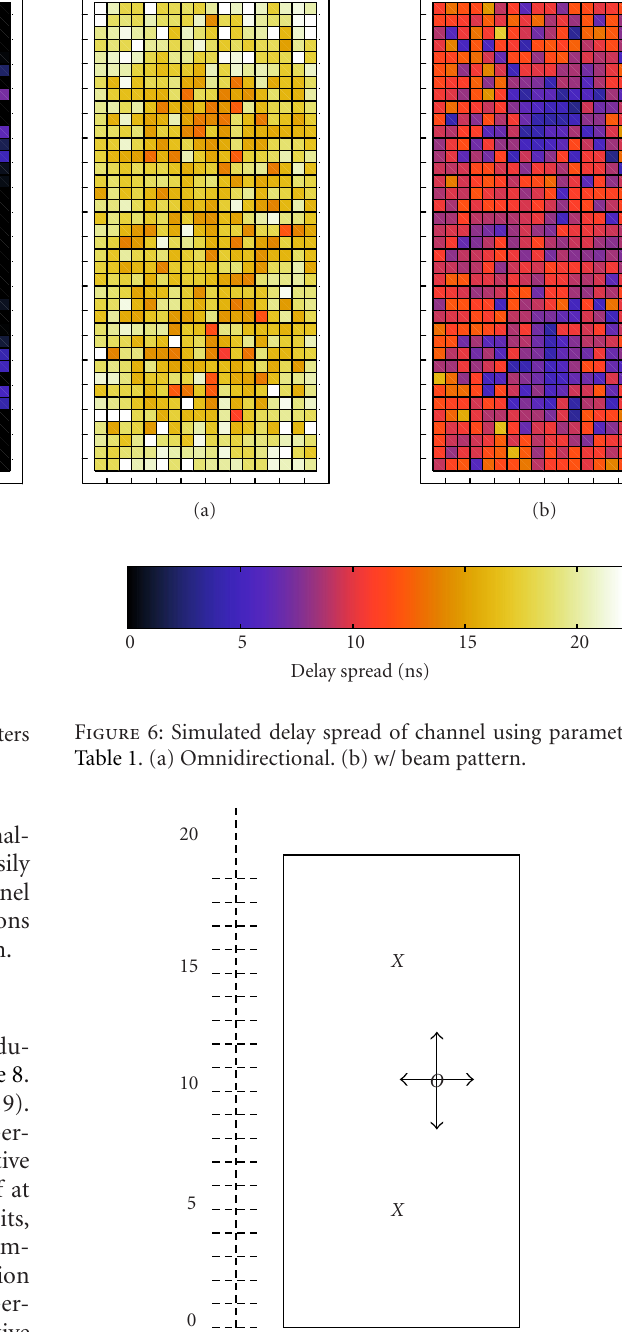
Figure 7: General simulation scenario. The two “ X ’s” represent the two base units. The “ O ” represents the mobile unit, which is posi- tioned at various locations in the room. The dimension of the room is 20 × 10 × 3m 3 . The base units are located at a height of 2 . 9m. The mobile unit is located at a height of 1 . 0 m. The mobile unit consists of a single element, a 4 × 4 planar array using a LOS fixed beam- former, and a 4 × 4 planar array using an adaptive